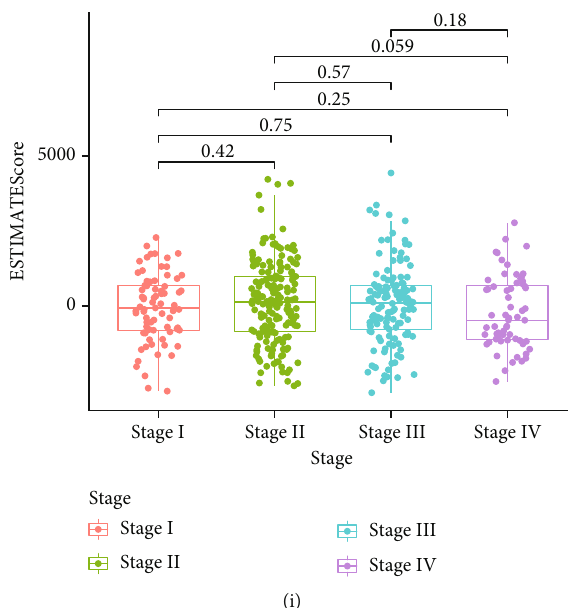
Figure 2: Relationship of scores showing clinicopathological staging features: (a – c) ImmuneScore in gender, age, and stage; (d – f) StromalScores in gender, age, and stage; (g – i) ESTIMATEScores in gender, age, and